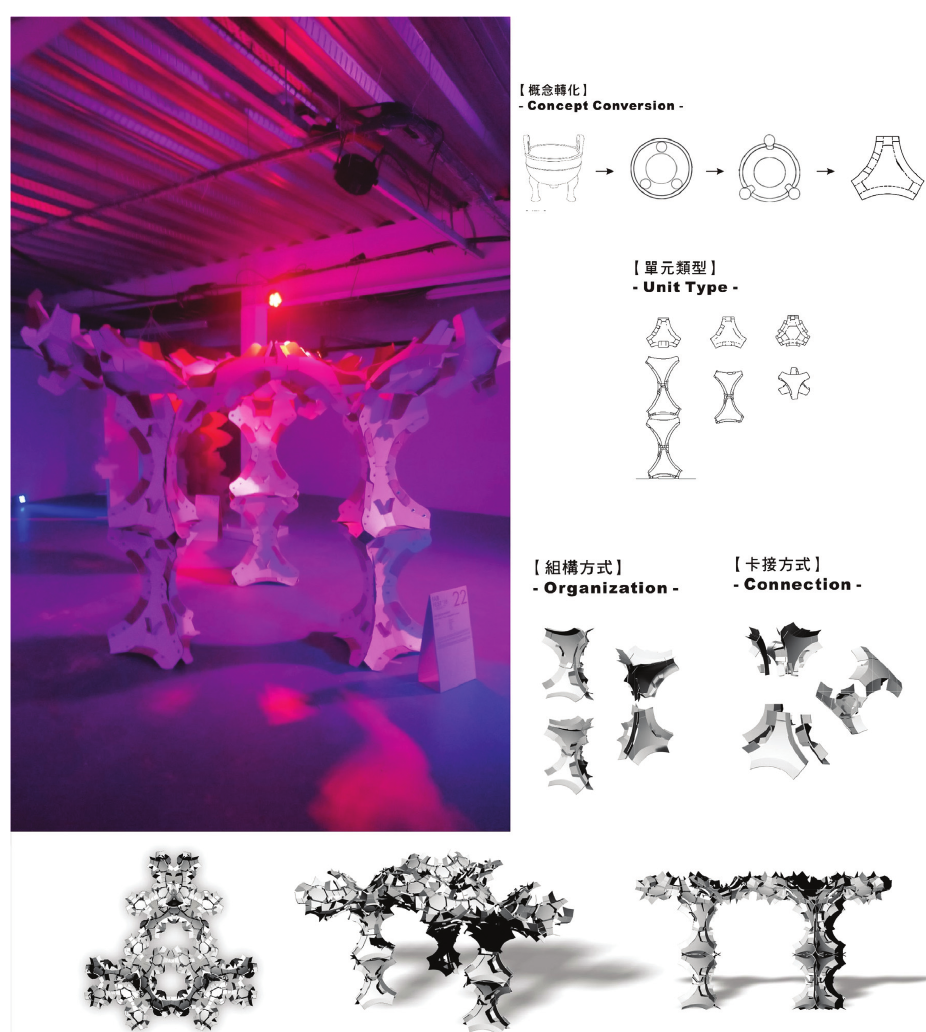
Figure 2: The orchid pavilion, a proto-architectural object assembled of discrete components and following more traditional form of Chinese architecture. The concept had been predefined by the designer with precise and specific means, computationally simulated, and visually analysed before the production and installation was